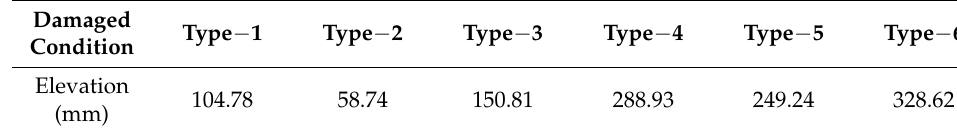
Table 4. Elevation (mm) of all damage conditions.